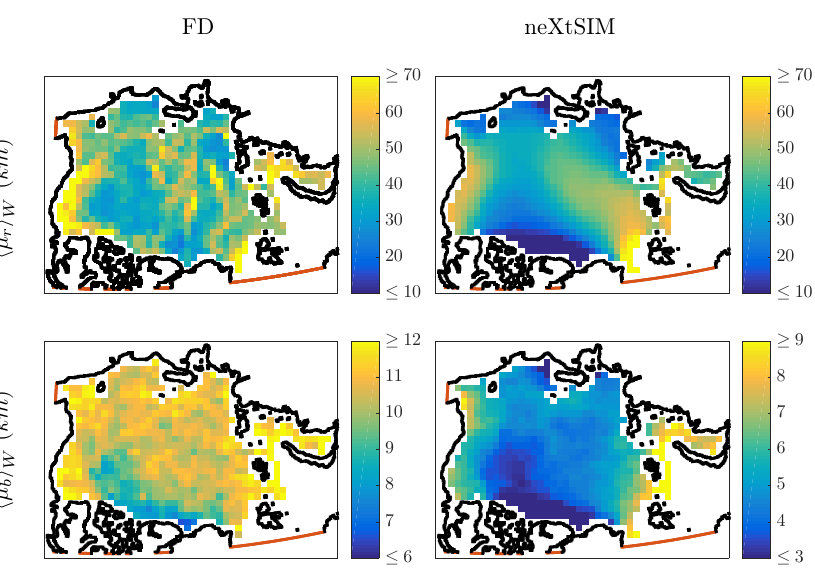
Figure 6. Mean over the winter period of µ r (t) and µ b (t) at t = 10 days. The calculated values are represented by coloured squares centred on the starting points x 0 shown in Fig. 3.